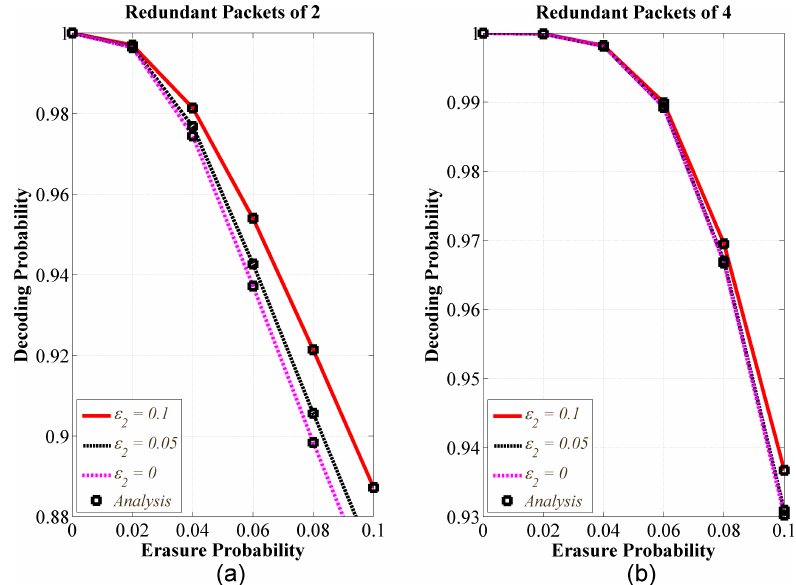
Figure 8. Decoding probability versus erasure probability with various erasure probabilities of the access link between ON 2 and CH; 2 ONs, K u = 30, and q = 256; ( a ) R 1 = R 2 = 2, R CH = 4; ( b ) R 1 = R 2 = 4, R CH =